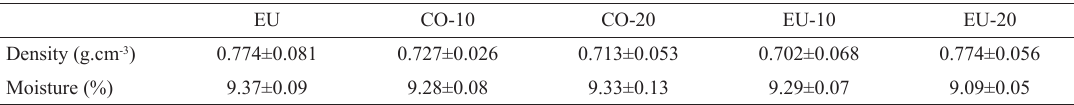
Table 4: Apparent density and moisture of the samples used for the thermal